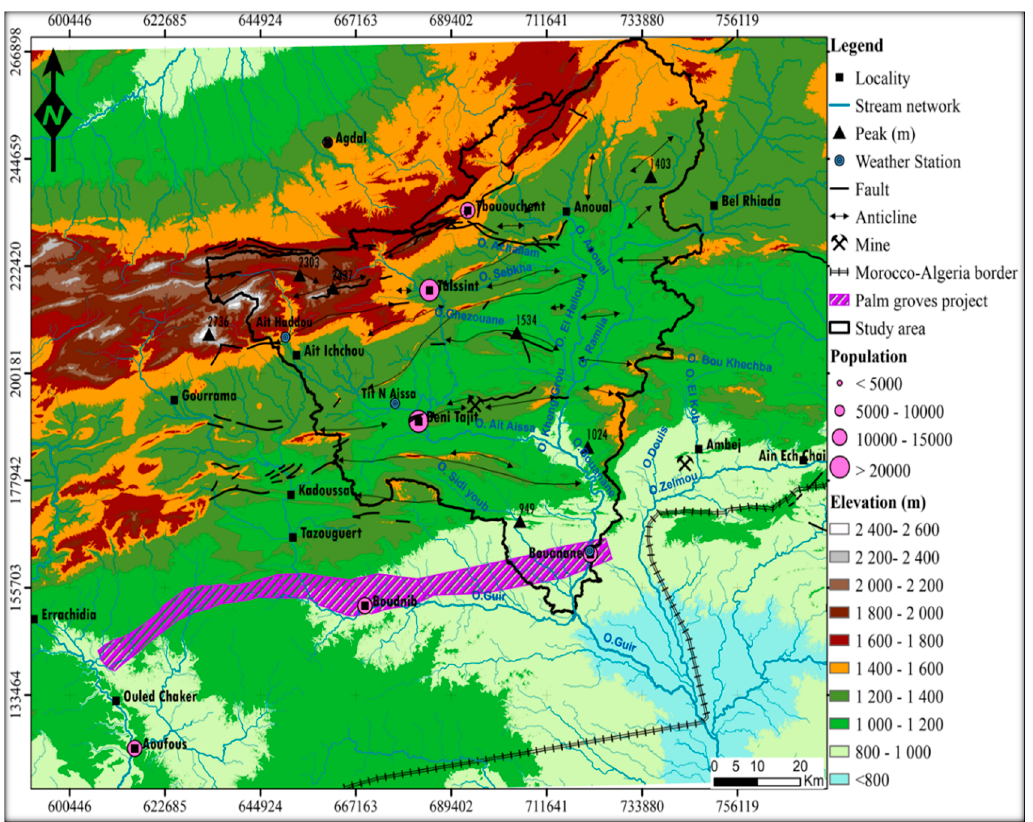
Figure 5. Morphological map and hydrological network of Eastern Upper Guir, compared with locations of human activities (urban centers, mines and palm plantation project).